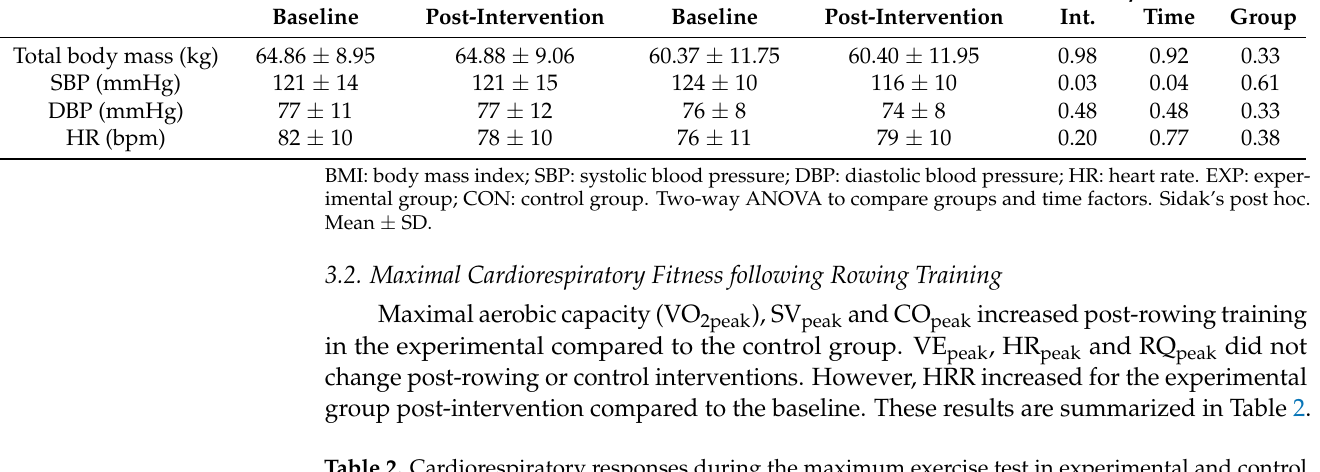
Table 2. Cardiorespiratory responses during the maximum exercise test in experimental and control groups at baseline and